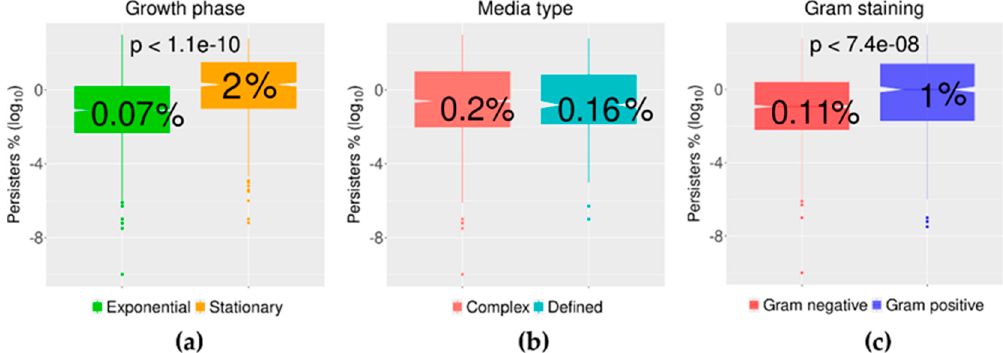
Figure 7. Significant di ff erences for the data distribution for the growth phase and Gram staining but not media type. Growth phase: the box plots represent the distribution of the level of persisters as the log 10 of the percentage of cells surviving the challenge of antibiotics. The median of the persisters was 0.07% for cells from cultures in the exponential growth phase and 2% for cells in the stationary phase. The significance of this di ff erence was calculated by a two-tail Welch’s t -test ( p < 1.1 × 10 − 10 ), which considers di ff erences in the size of the samples compared. Media type: the data by media type (either complex or defined media) of the cell cultures used for the challenge with antibiotics showed no di ff erences. Gram staining: data clustered by Gram staining. The di ff erence in the median of the percentage of persisters was significant to p < 7.4 × 10 − 8 .